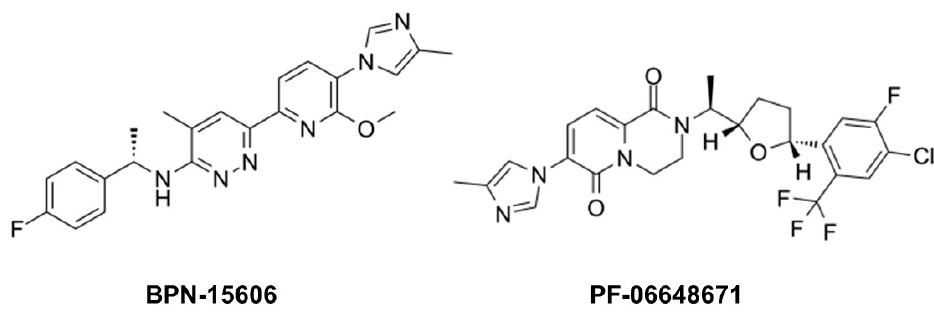
Figure 10. Example γ -secretase modulators (GSMs).